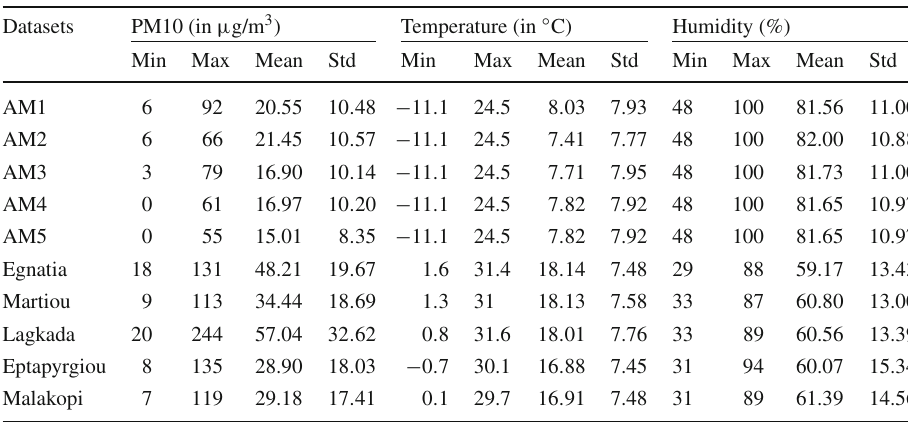
Datasets PM10 (in µ g/m 3